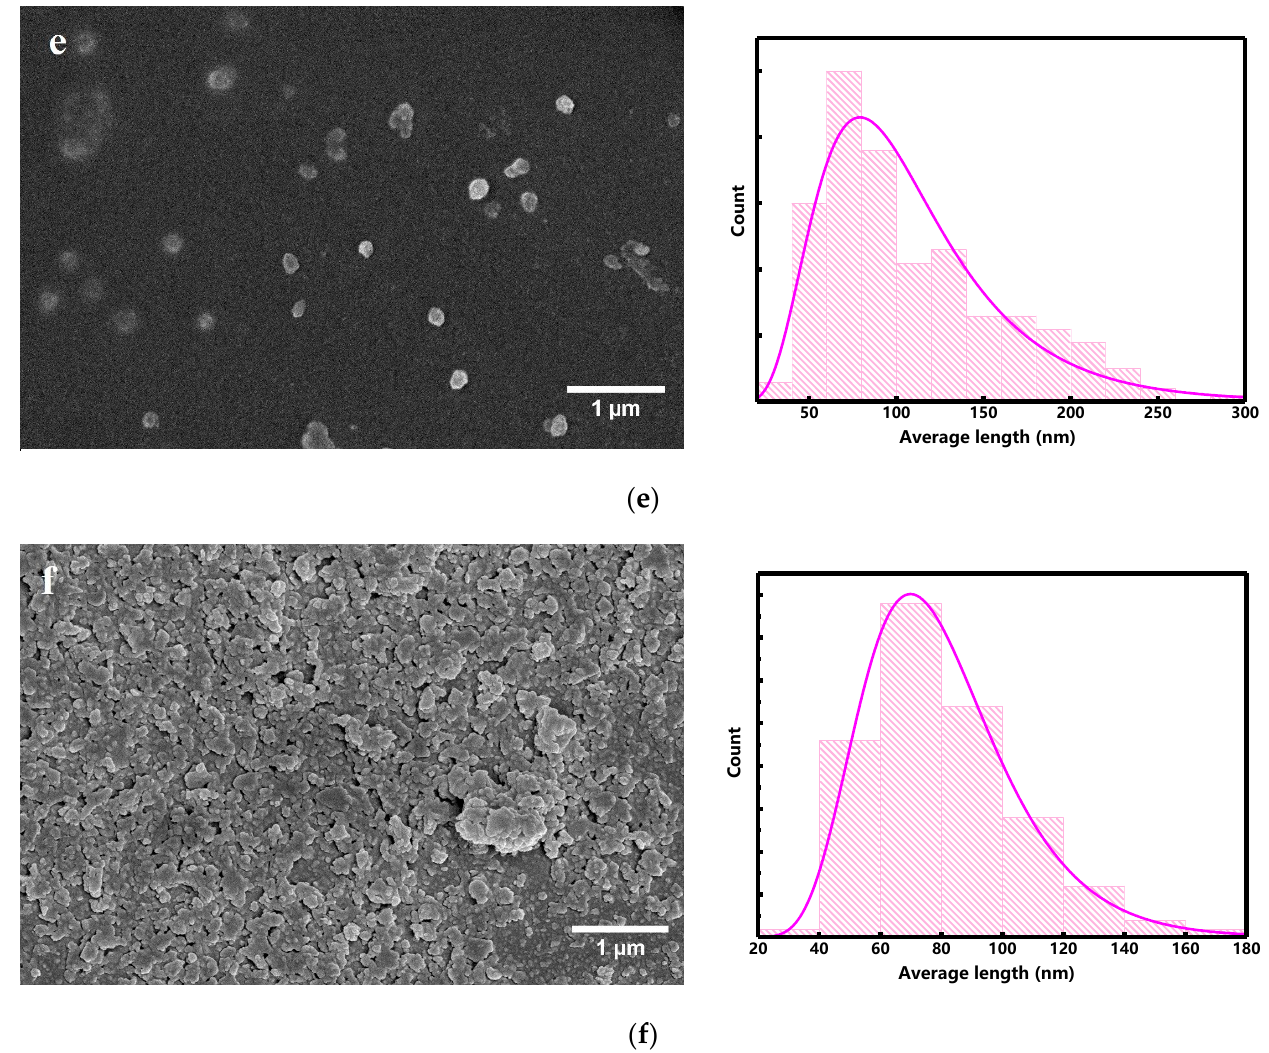
Figure 3. FESEM images and histograms of the particle size distribution of Mn 52 Al 45 . 7 C 2 . 3 milled at different times and containers: ( a ) 2 h cylindrical, ( b ) 5 h cylindrical, ( c ) 10 h cylindrical, ( d ) 2 h barrel, ( e ) 5 h barrel, and ( f ) 10 h barrel.